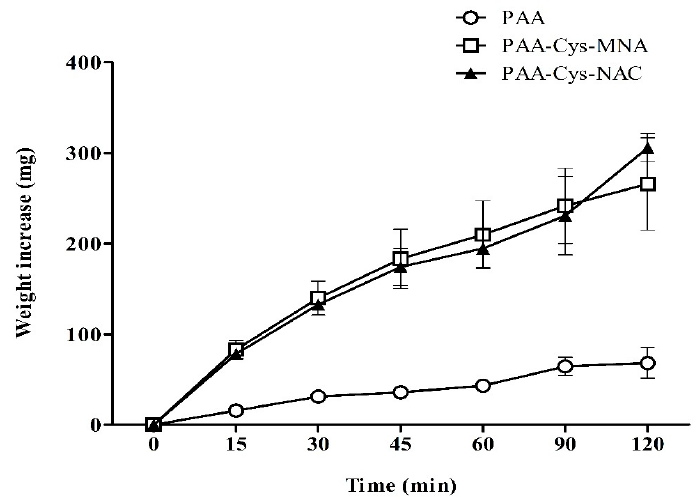
Figure 9. Swelling behavior of unmodified PAA and S-protected thiolated PAA conjugates. The study was carried out in 50 mM phosphate buffer pH 6.8. The data are shown as mean ± SD (n = 3).